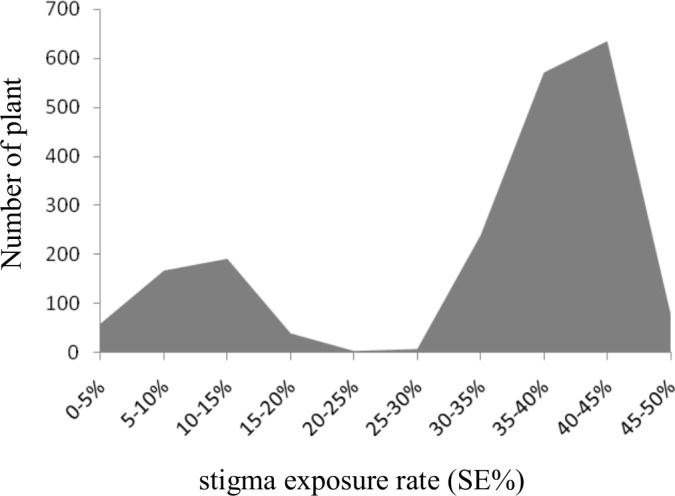
Distribution of the stigma exposure rate in the F2 population.